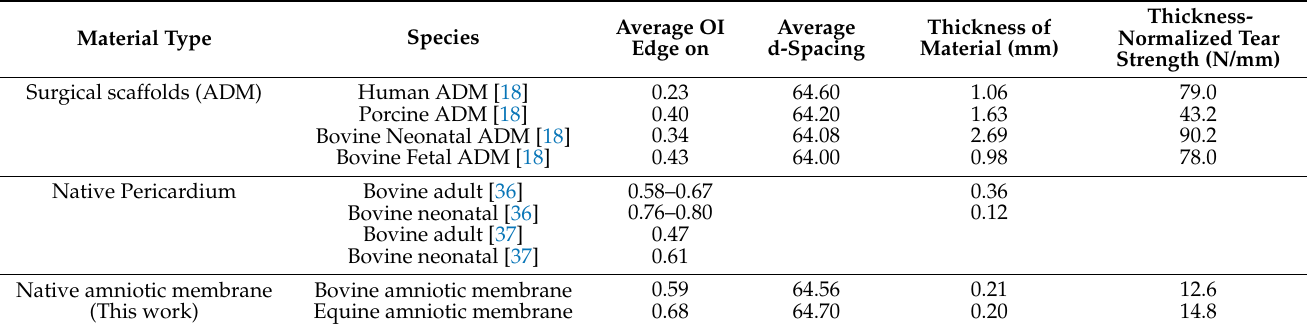
Table 4. Structure and strength comparison of acellular dermal matrix, pericardium, and amni- otic